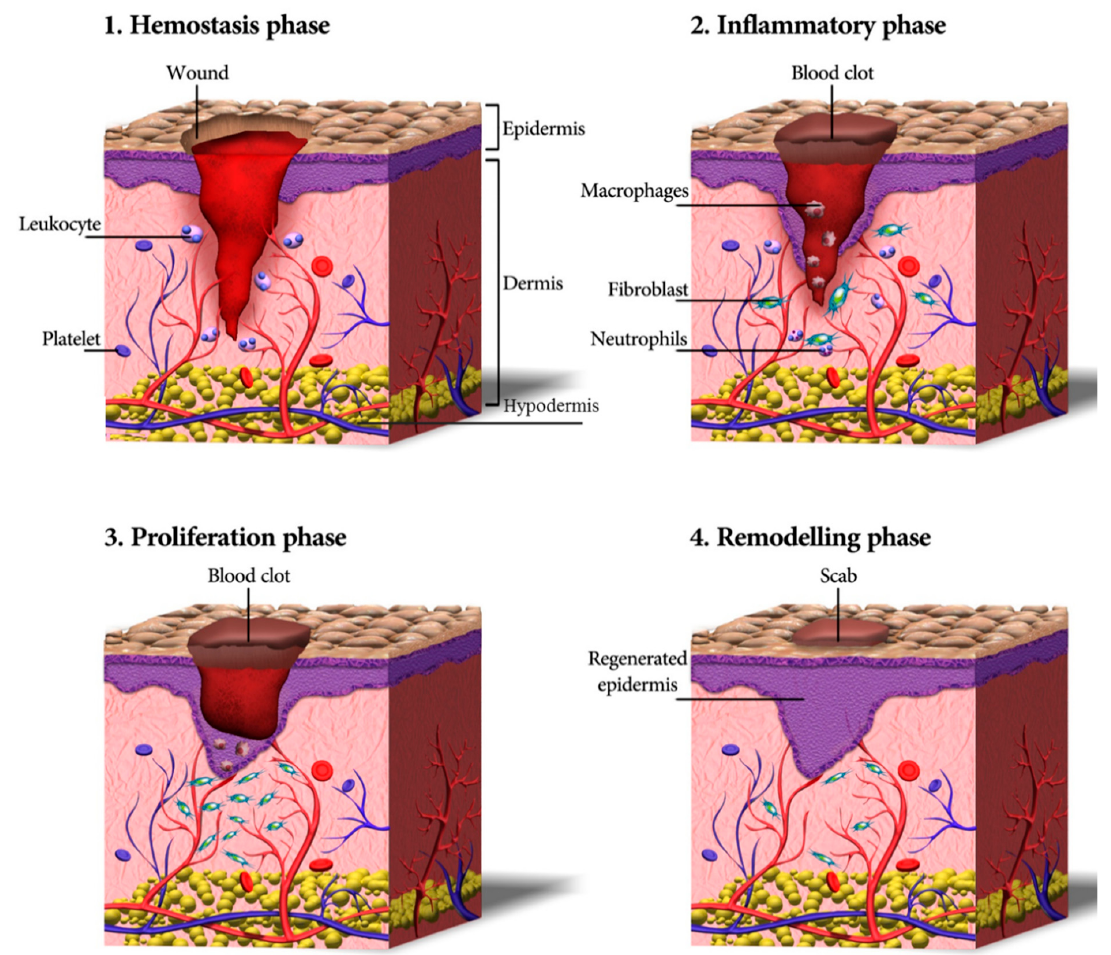
Figure 2. A schematic depicting the process of wound healing, including four continuous phases— homeostasis, inflammation, proliferation, and remodeling. In these four overlapping stages. First, blood platelets are activated to form a blood clot and have also a role in leukocyte recruitment. Next, neutrophils and macrophages clean the wound site from dead cells, bacteria, and other pathogens or debris. Then, fibroblasts migrate, proliferate, and activate the angiogenesis process. Finally, granulation tissue is formed, the extracellular matrix proteins are deposited to reconstitute the dermal tissue, and the epidermis is regenerated. Eventually, many of the formed capillaries and fibroblasts